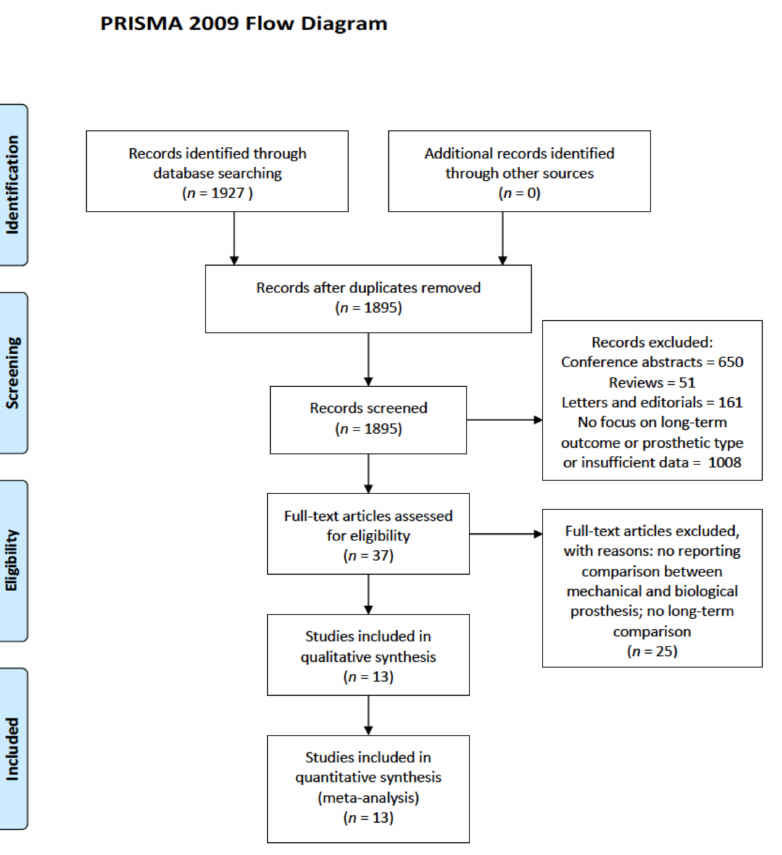
Figure 1. Study selection according to the Preferred Reporting Items for Systematic Reviews and Meta-Analyses (PRISMA), presented as a flow